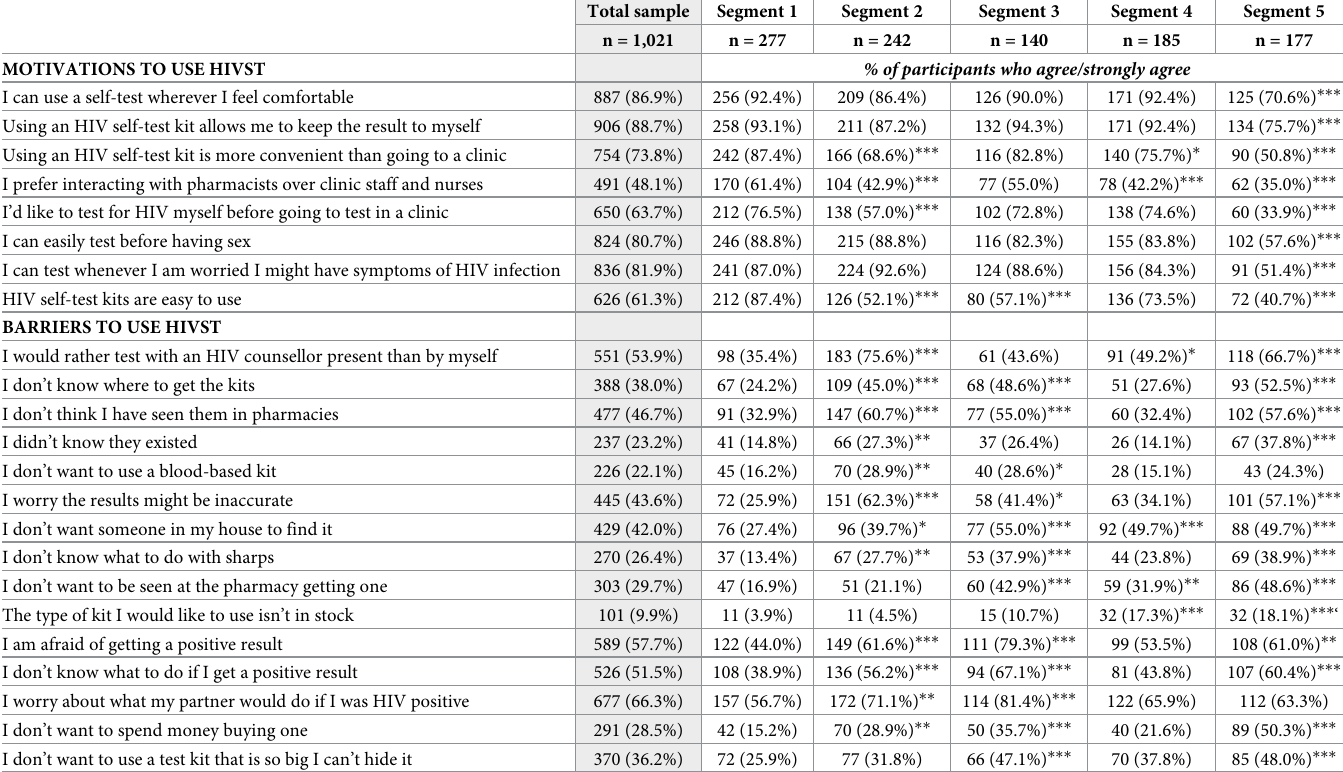
Table 4. Motivations and barriers to use HIVST, by